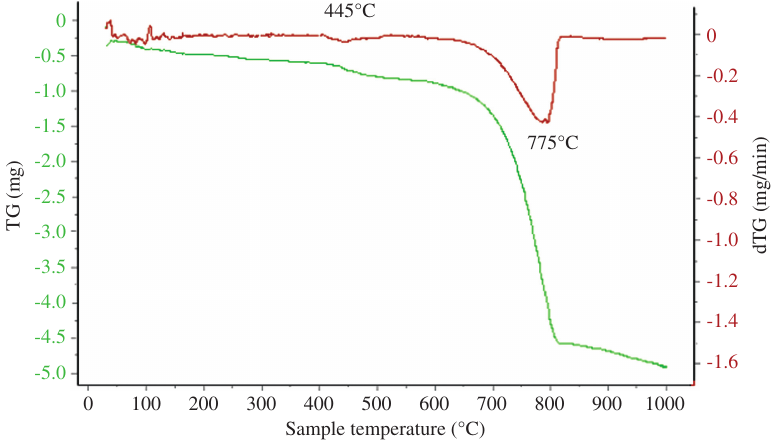
Figure 13 TGA graph of TPFA20-28